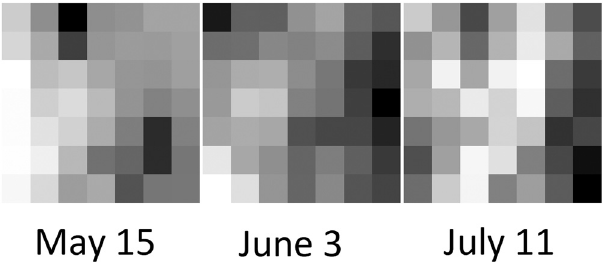
Figure 2: Interpolations using the same gain and threshold settings with di ff erent soil moisture conditions. Each survey was conducted with gain set to 60, threshold at − 40.